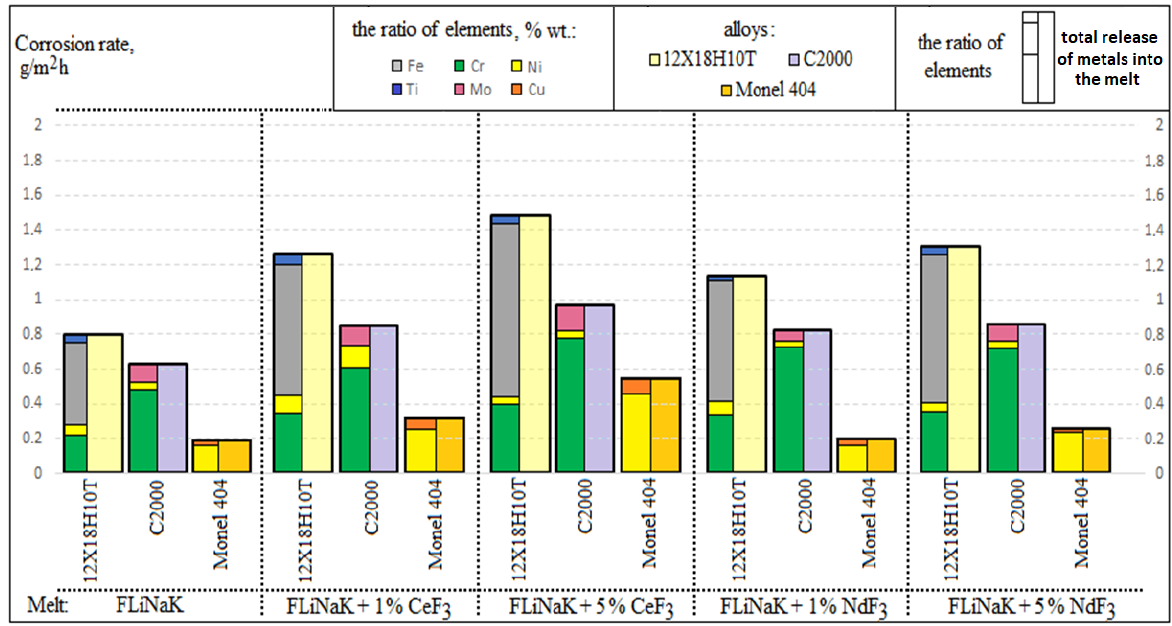
Figure 4. Results of the chemical analysis.